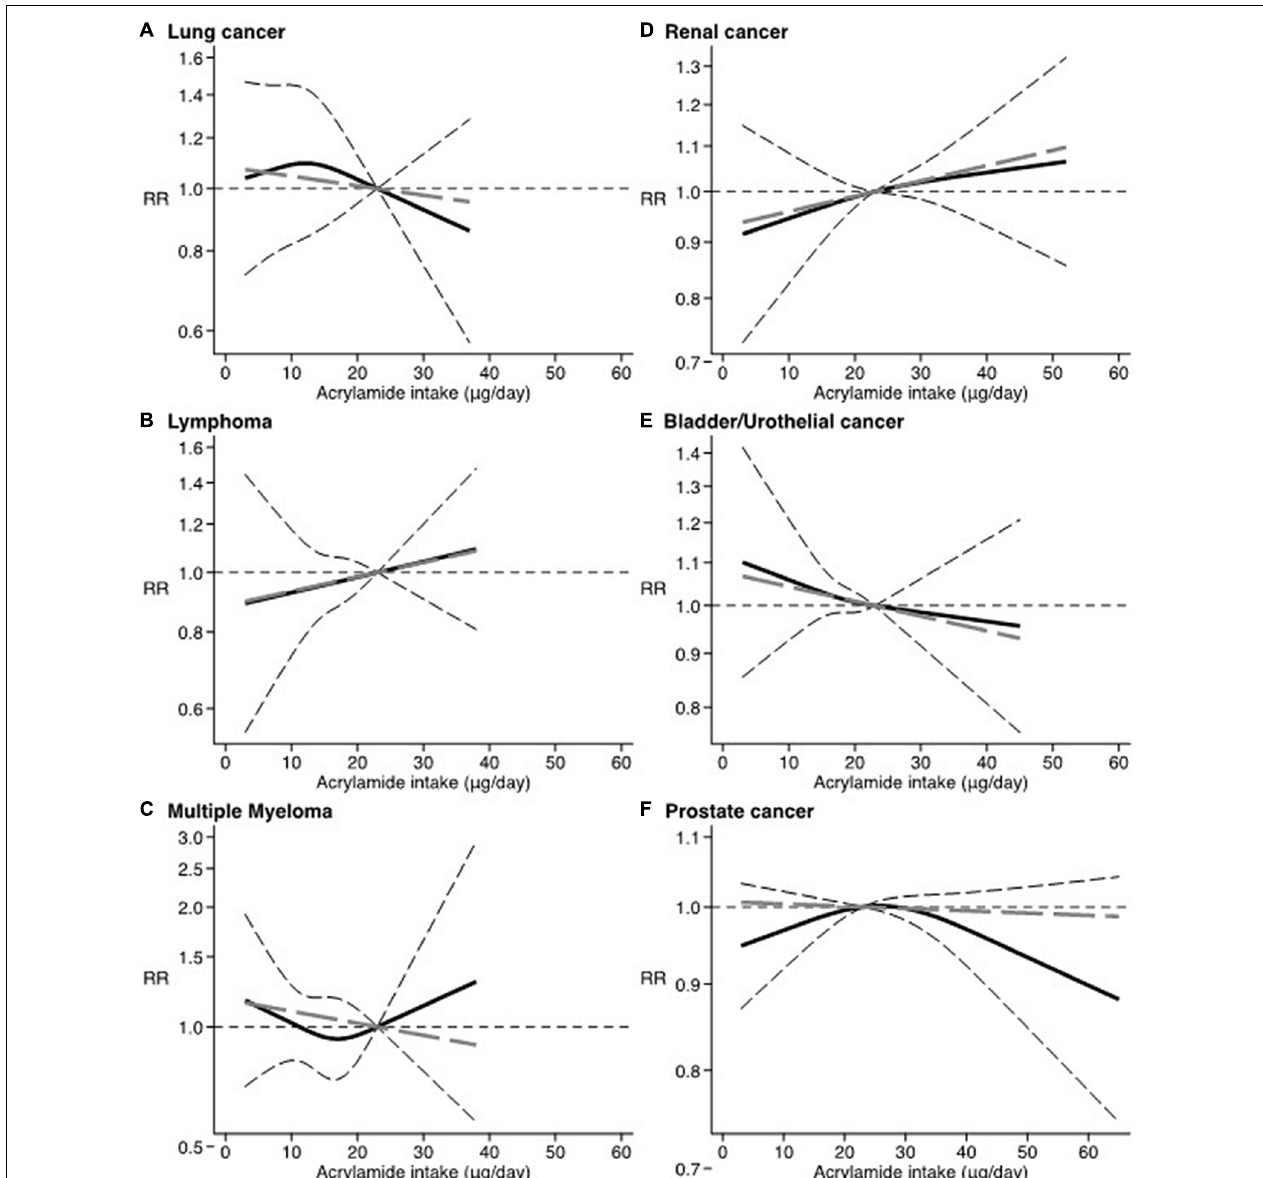
FIGURE 3 | Dose-response. Spline curve (black solid line) with 95% confidence limits (black dashed lines). Linear trend (gray long-dashed line). RR: relative risk. Reference value of dietary acrylamide exposure: 23 µ g/day. (A) Lung cancer (3, 19). (B) Lymphoma (16, 75). (C) Multiple myeloma (16, 75). (D) Renal cancer (17, 21, 30, 36, 59, 73, 74). (E) Bladder/Urothelial cancer (17, 21, 59). (F) Prostate cancer (17, 20, 22, 24, 27, 34,